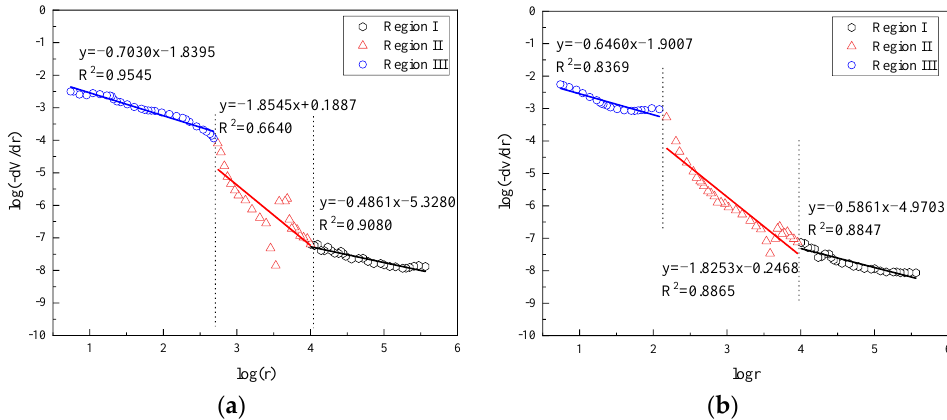
Figure 14. Multifractal characteristics of OPC0 at different ages under Pfeifer and Avnir’s model. ( a ) 3 days, ( b ) 28 days.